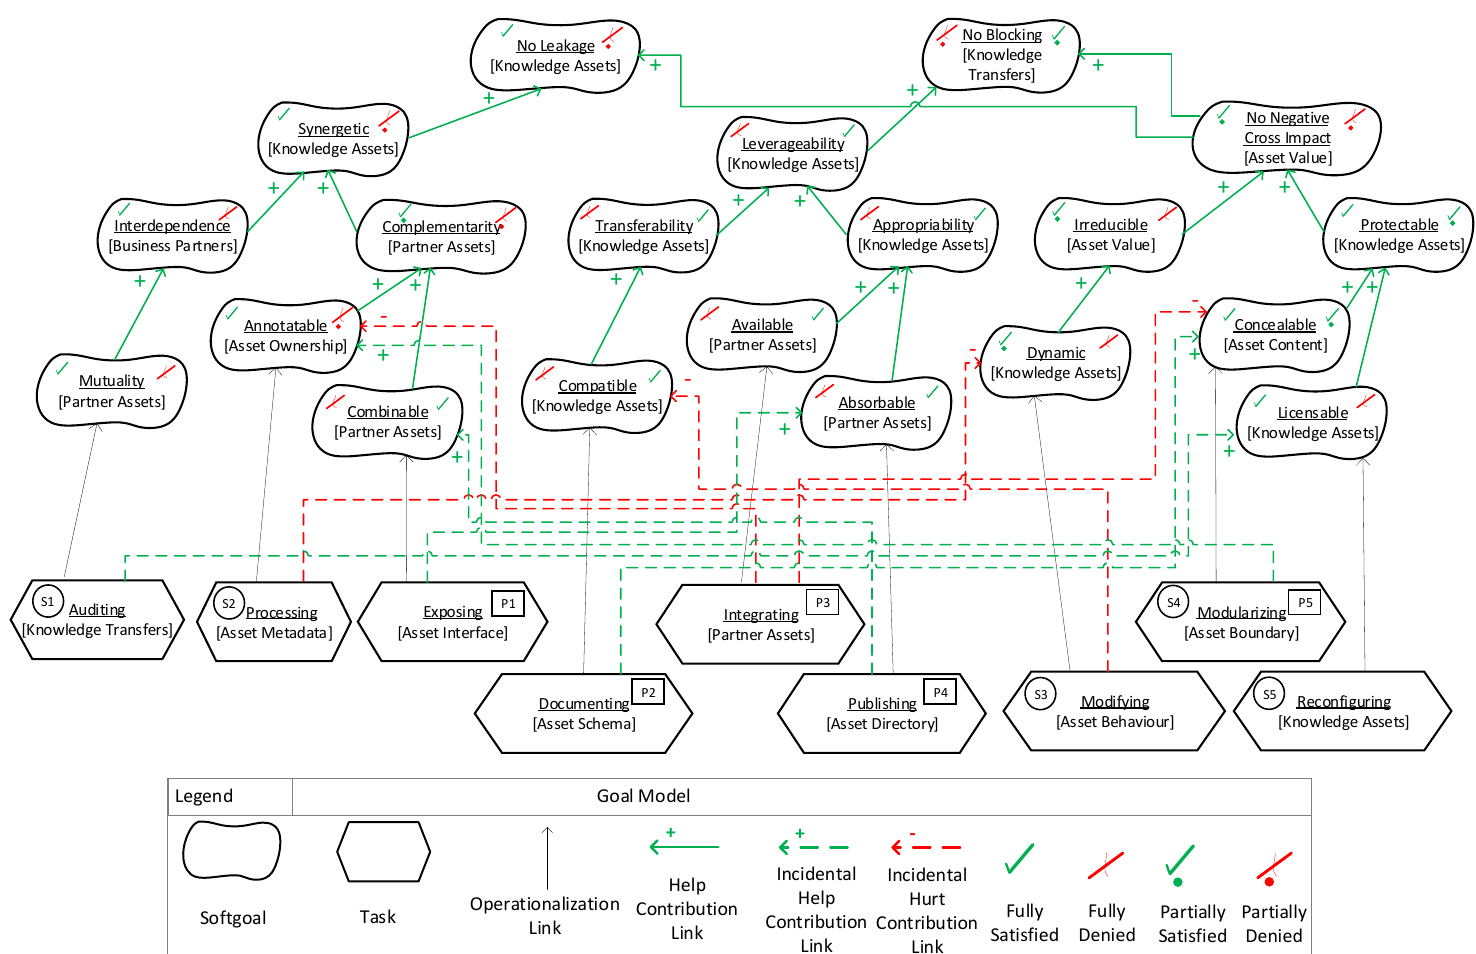
Figure 3. Goal model of As-Is scenario representing knowledge sharing goals and potential tasks, synthesized from sources listed in Table 1 and Table